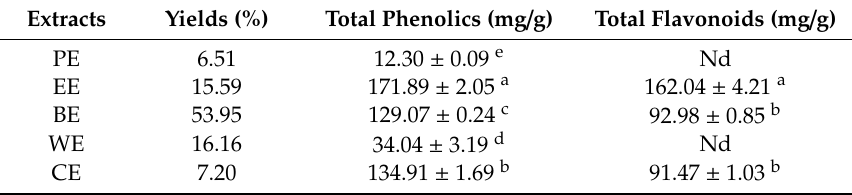
Table 2. Total flavonoids and phenolics contents of the five crude extracts of R. crenulata. Extracts Yields